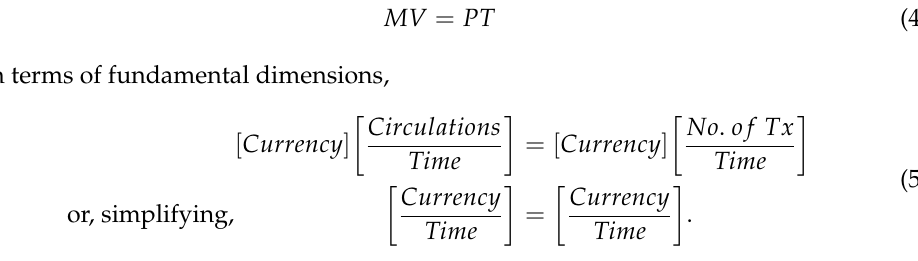
Contribution to